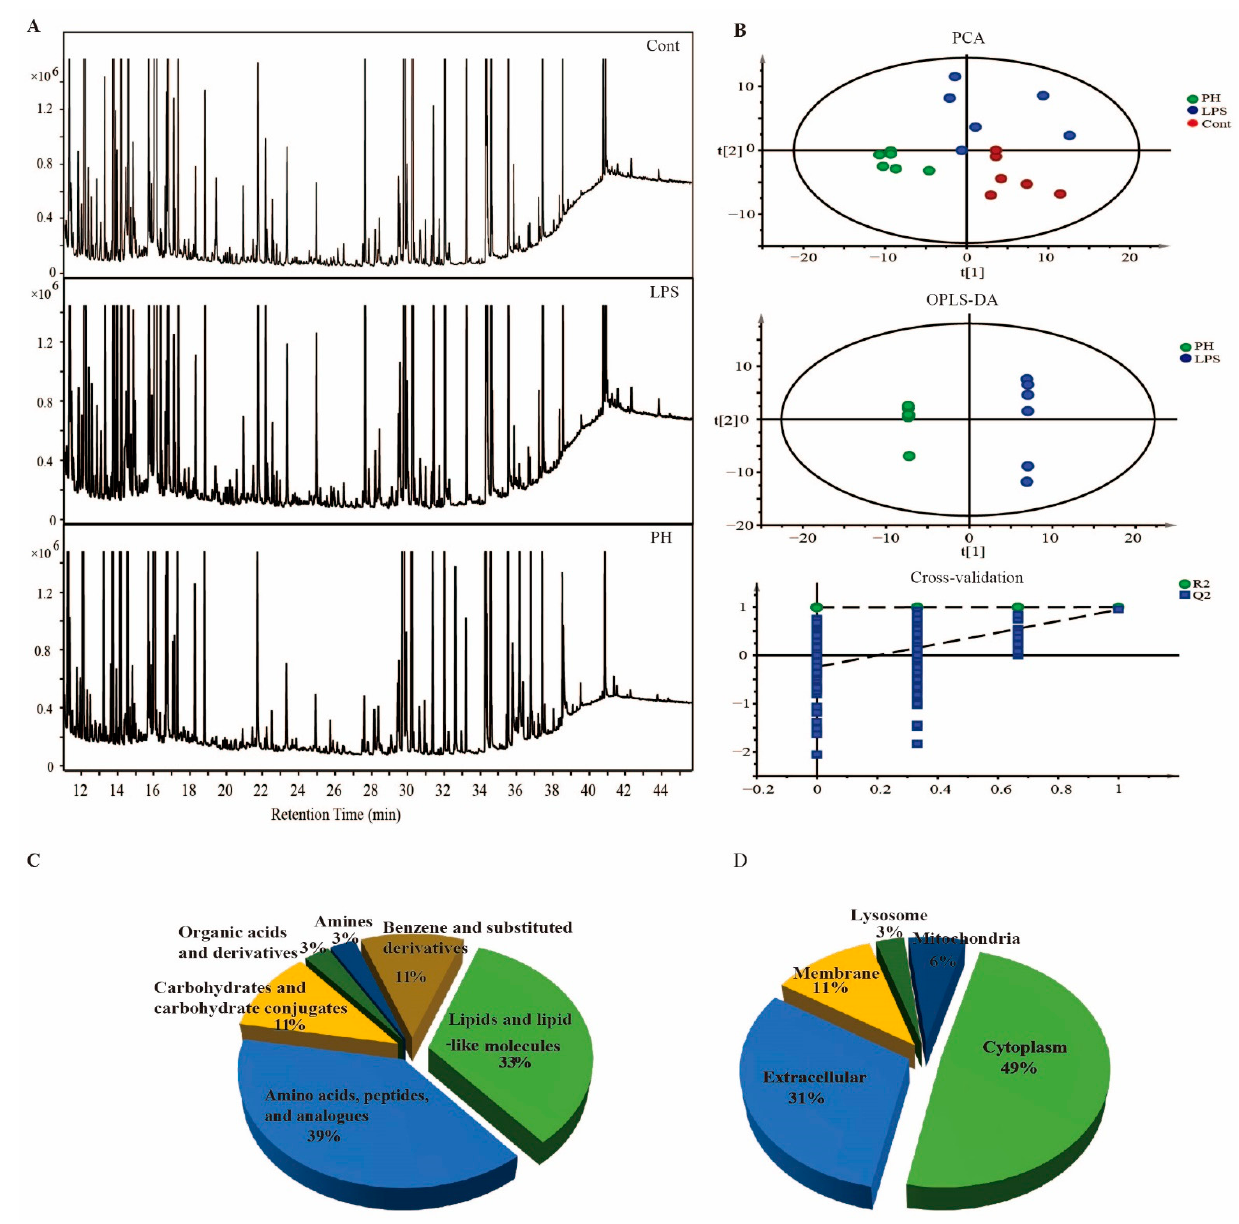
Figure 9. Non-targeted metabolomics analysis presented key differential metabolites between LPS-challenged and pectolinarin mice. ( A ) Representative GC-MS total ion chromatograph of serum from the control group (Cont), LPS group, and pectolinarin (50 mg/kg)-treated group (PH) mice. ( B ) Multivariate statistical analysis of GC-MS metabolic profiling data. PCA scores plot and OPLS-DA scores plot were derived from GC-MS spectra of three groups of mice (LPS, blue dot; Cont, red dot; PH, green dot) and statistical validation of the OPLS-DA model by permutation testing. ( C ) Chemical classification of the key differential metabolites based on the annotations of Human Metabolome Database (www.hmdb.ca, accessed on 3 March 2022) and their corresponding percentages. ( D ) Cellular locations of the key differential metabolites based on the annotations of the Human Metabolome Database (www.hmdb.ca, accessed on 3 March 2022) and their corresponding percentages. PCA, principle component analysis; OPLS-DA, pair-wise orthogonal projections to latent structures discriminate